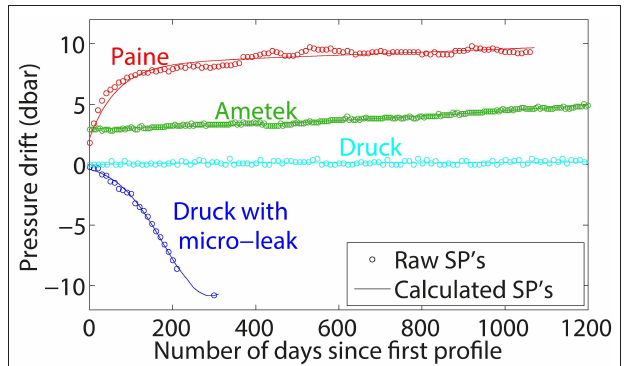
FIGURE 8 | Percentage of pressure adjustments vs. the number of cycles, from 2,779 APEX floats. float types (the auto-correcting floats, e.g., SOLO, PROVOR), but is done as part of the real-time and delayed-mode adjustment process for other float types (the non-auto-correcting floats, e.g., APEX, NAVIS).